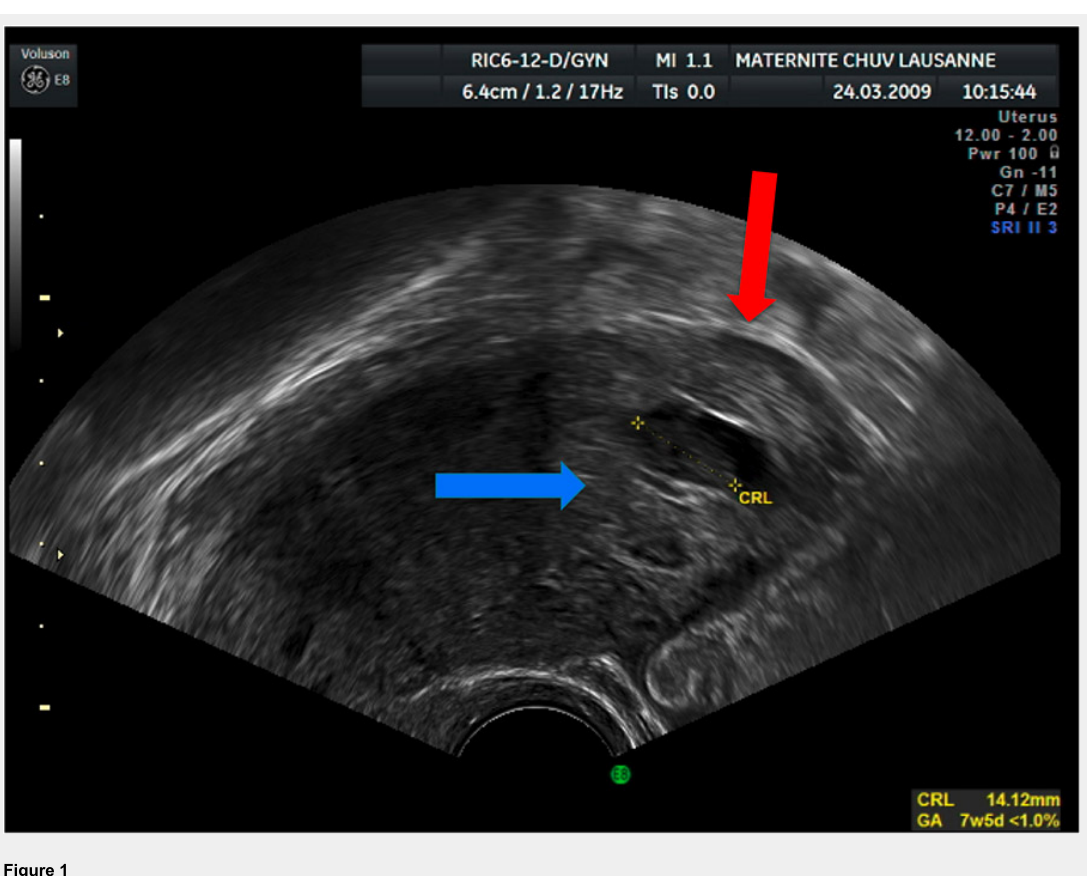
Figure 1 TVUS sagittal image showing an eccentric GS, blue arrow, surrounded by a thin myometrial layer, red